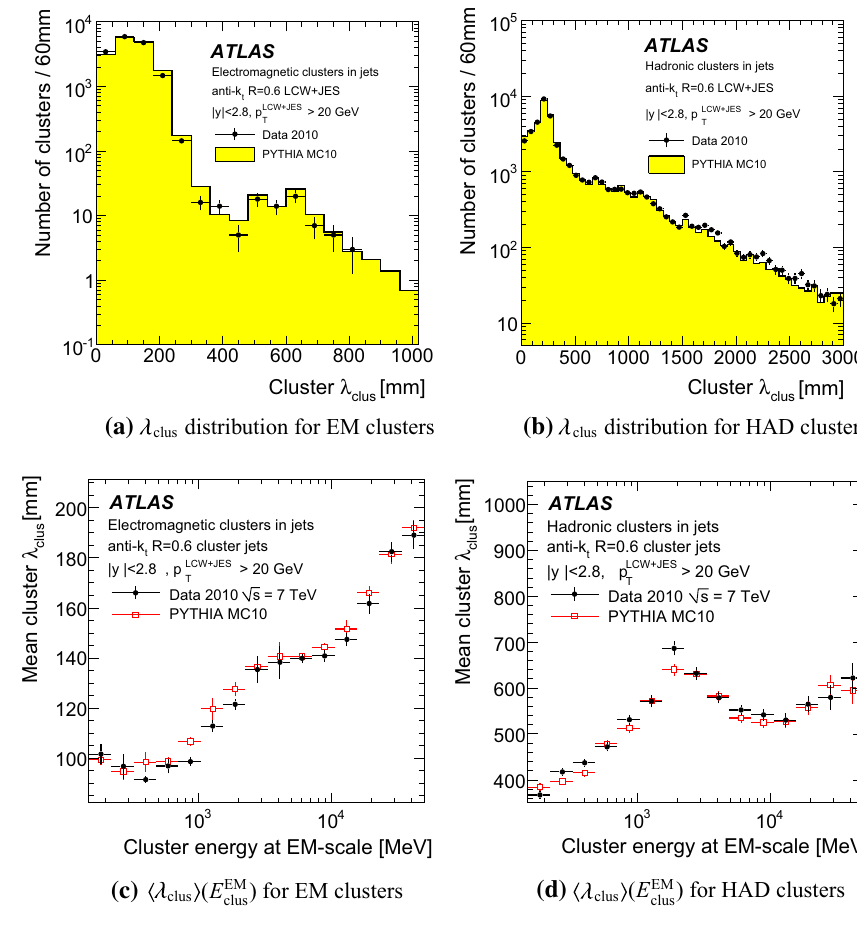
ρ 0 and E 0 in Eq. (34) are the same as the ones used in Eq. (30). distribution in the PreSampler and the ρ cell The E EM cell distribution in the the EMB2 sampling of the central elec- tromagmetic calorimeter are shown in Fig. 12 for cells in topo-clusters inside jets reconstructed with the anti- k t algo- rithm using a distance parameter R = 0 . 6. Discrepancies between data and MC simulations mostly in the high-end tails of the distributions indicate more compact electromag- netic showers in the simulation. This is also seen in Fig. 13a for the ρ cell distribution for the same kind of jets in the EME2 sampling of the electromagnetic end-cap calorimeter. Bet- ter agreement between data and MC simulations over the whole spectrum is observed for the ρ cell distributions in the first module ( FCAL0 ) of the forward calorimeter shown in Fig. 13b, and in the second sampling of the central hadronic ( Tile1 ) and the first sampling of the hadronic end-cap ( HEC0 ) calorimeters shown in Fig. 14. Overall, the quality of the modelling of the cell signal densities is sufficient for topo-cluster calibration purposes. The figures are taken from Ref.